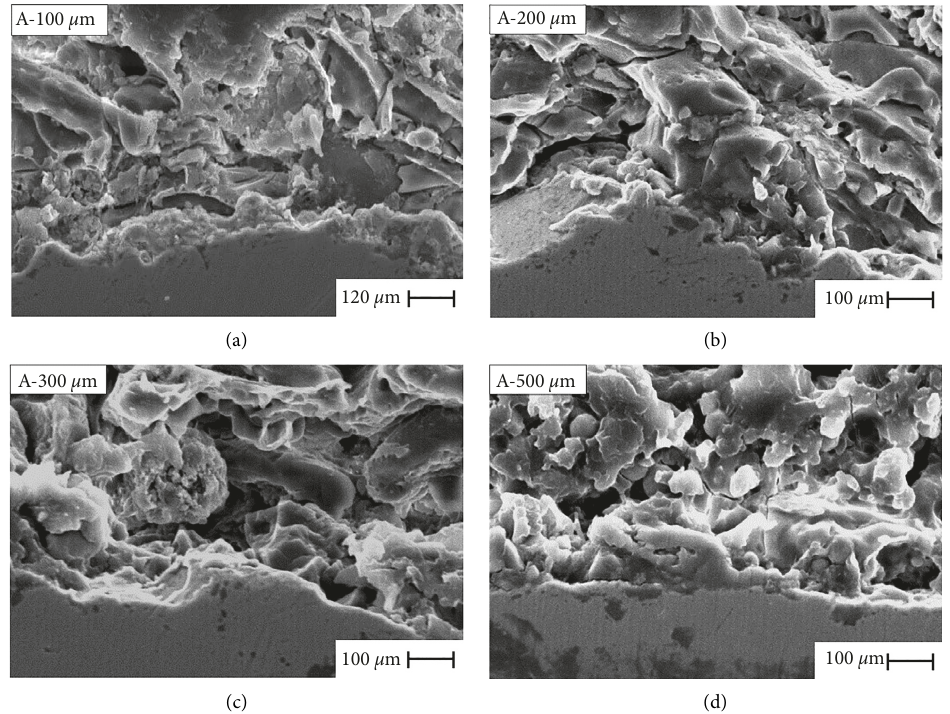
Figure 9: Cross section microstructure of different thicknesses for coating. (a) 100 μ m. (b) 200 μ m. (c) 300 μ m. (d) 500 μ m.